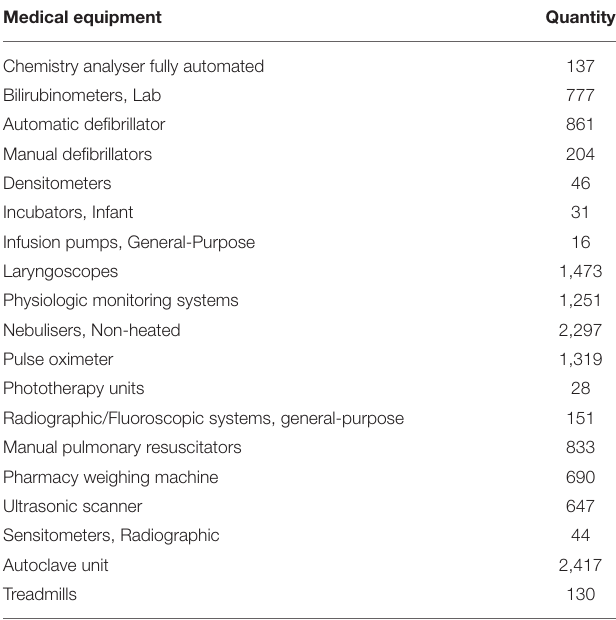
TABLE 2 | Medical equipment category and